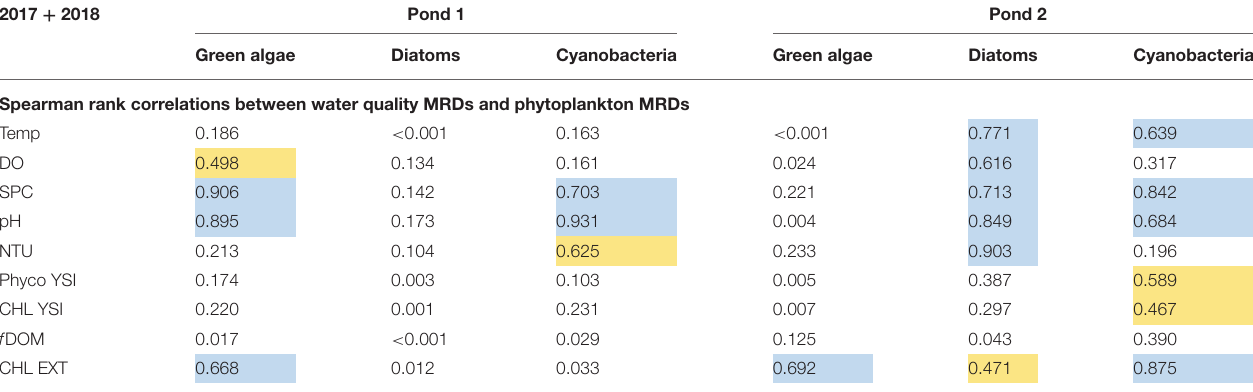
TABLE 1 | Spearman rank correlations between the mean relative differences of water quality parameters and MRD values of phytoplankton functional